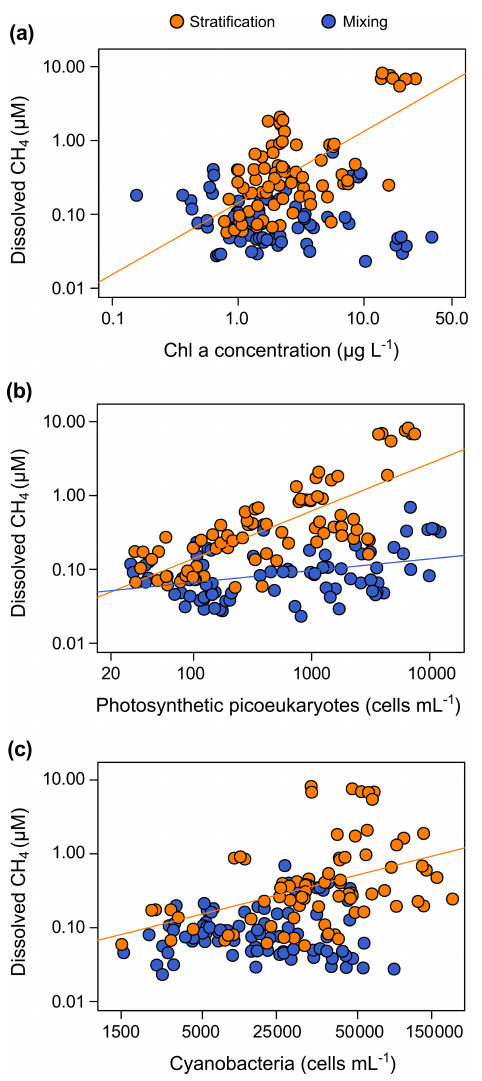
Figure 8. Phytoplanktonic variable coupled with the dissolved CH 4 concentration in the oxic waters. (a) The dissolved CH 4 concen- tration was significantly related to the chlorophyll a concentra- tion during the stratification period ( p value < 0 . 001), but they were not related during the mixing period ( p value = 0.469). The relationship during the stratification period was a power func- tion (CH 4 = 0.14 Chl a 0 . 97 , n = 78, adjusted R 2 = 0 . 40). (b) Re- lationships between dissolved CH 4 concentration and the abun- dance of photosynthetic picoeukaryotes (PPEs) during the stratifica- tion period (CH 4 = 0.0072 PPEs 0 . 65 , n = 78, adjusted R 2 = 0 . 55, p value < 0 . 001) and the mixing period (CH 4 = 0.032 PPEs 0 . 16 , n = 82, adjusted R 2 = 0 . 12, p value < 0 . 001). (c) Relationship be- tween dissolved CH 4 concentration and the cyanobacteria abun- dance (CYA; cellsmL − 1 ). A power function described the relation- ship between the dissolved CH 4 and the CYA during the stratifica- tion period (CH 4 = 0.0017 CYA 0 . 53 , n = 78, adjusted R 2 = 0 . 17, p value < 0 . 001). The relationship was not significant during the mix- ing period ( p value = 0.666).